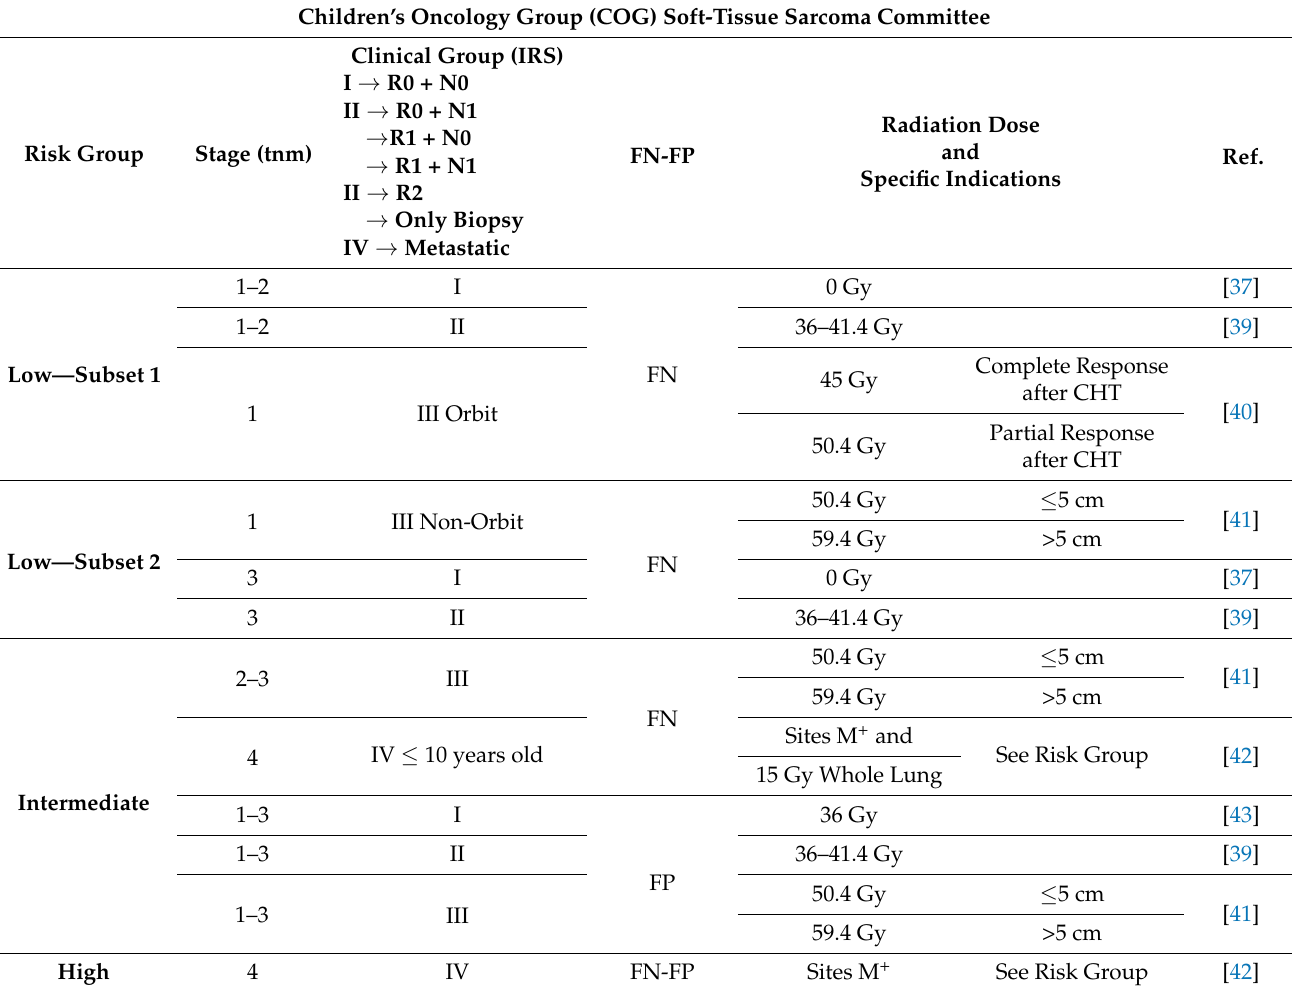
RMS prognostic groups based on Children’s Oncology Group (COG) soft-tissue Sarcoma